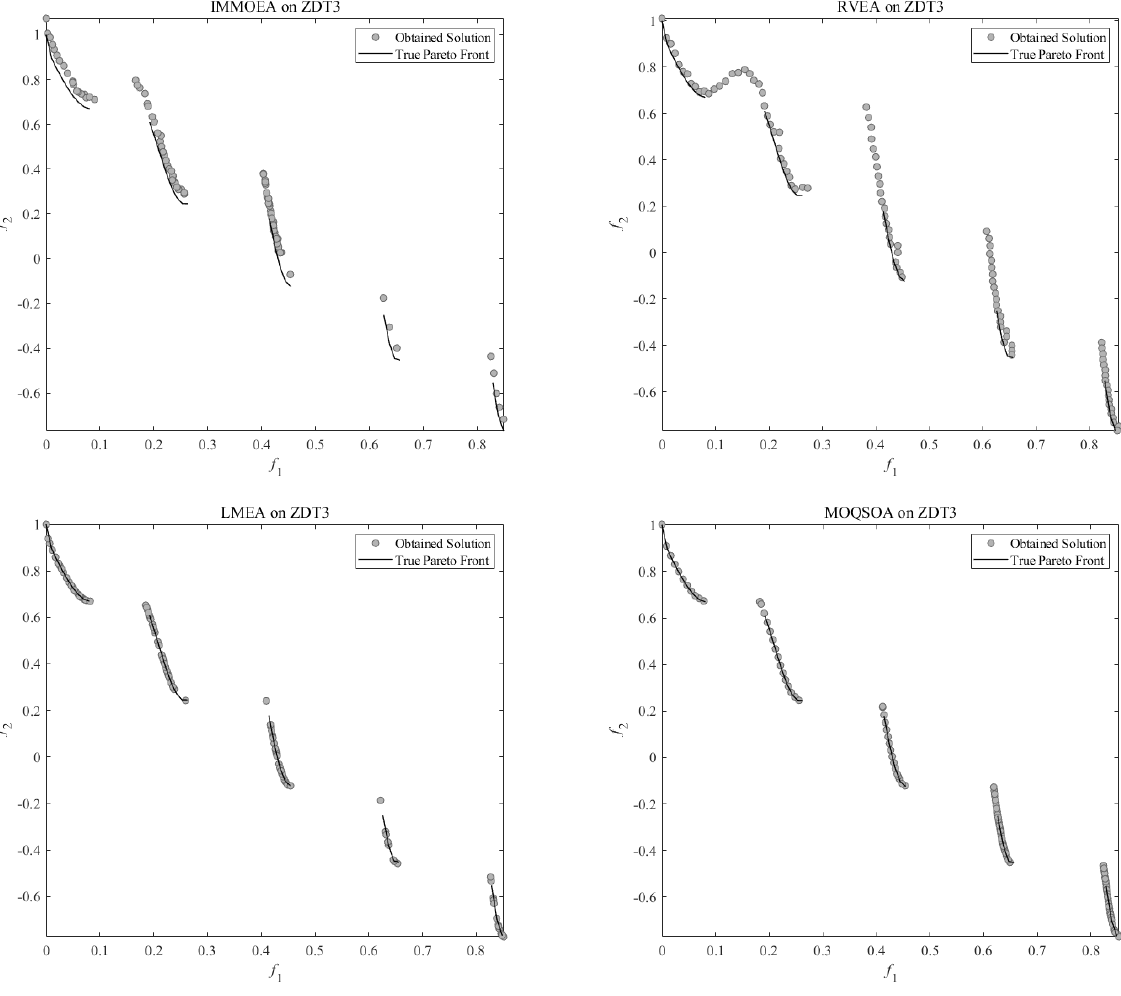
Table 3. IGD metric results.